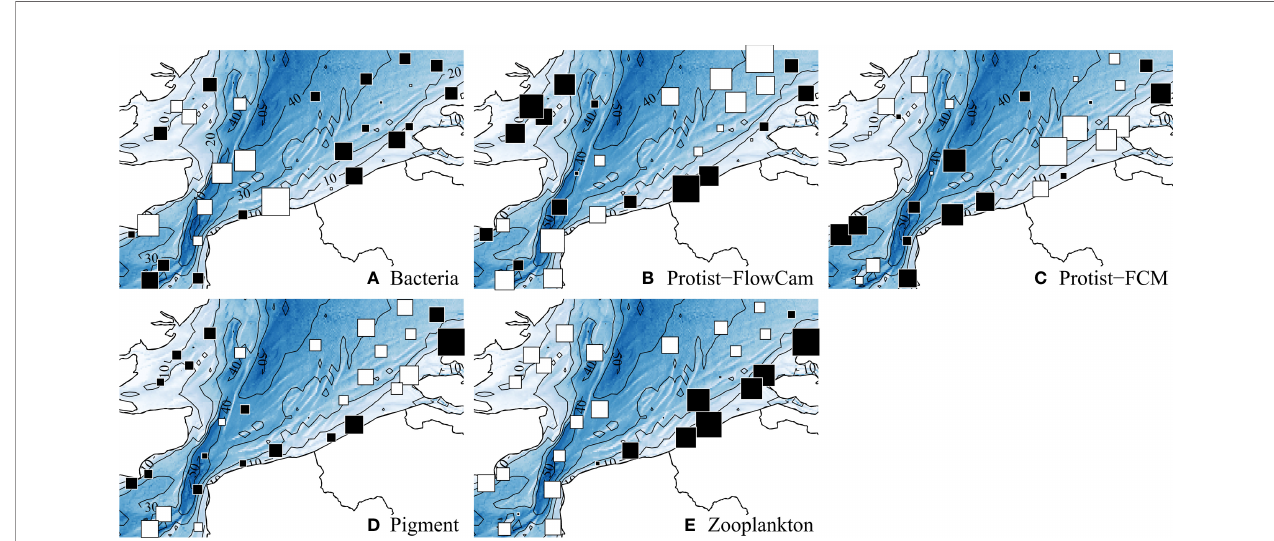
FIGURE 3 | Spatial distributions of the total density for each biotic component. Values were standardized with mean = 0 and SD = 1. White and black squares, values respectively lower and greater than the mean; square size is proportional to the deviation from the mean. A summary of the ranges is provided in the supplementary material, Supplementary Material